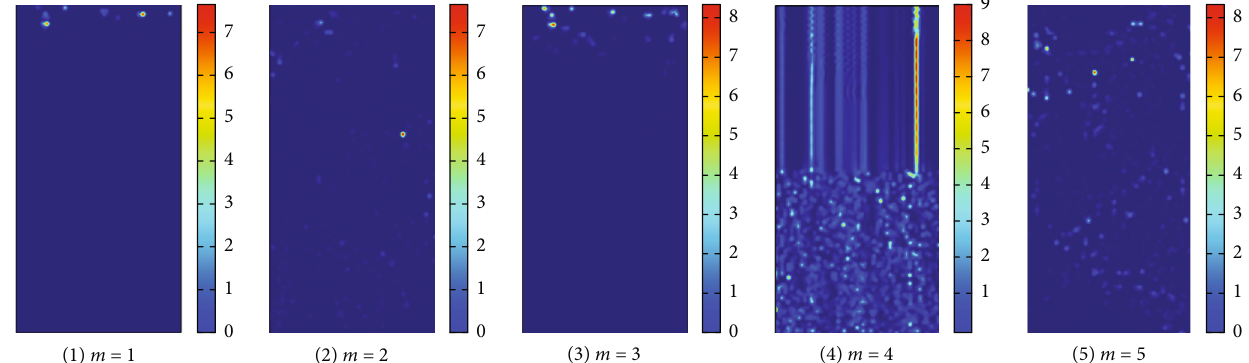
Figure 6: Mises stress distribution of microelement of rock mass with di ff erent homogeneity.